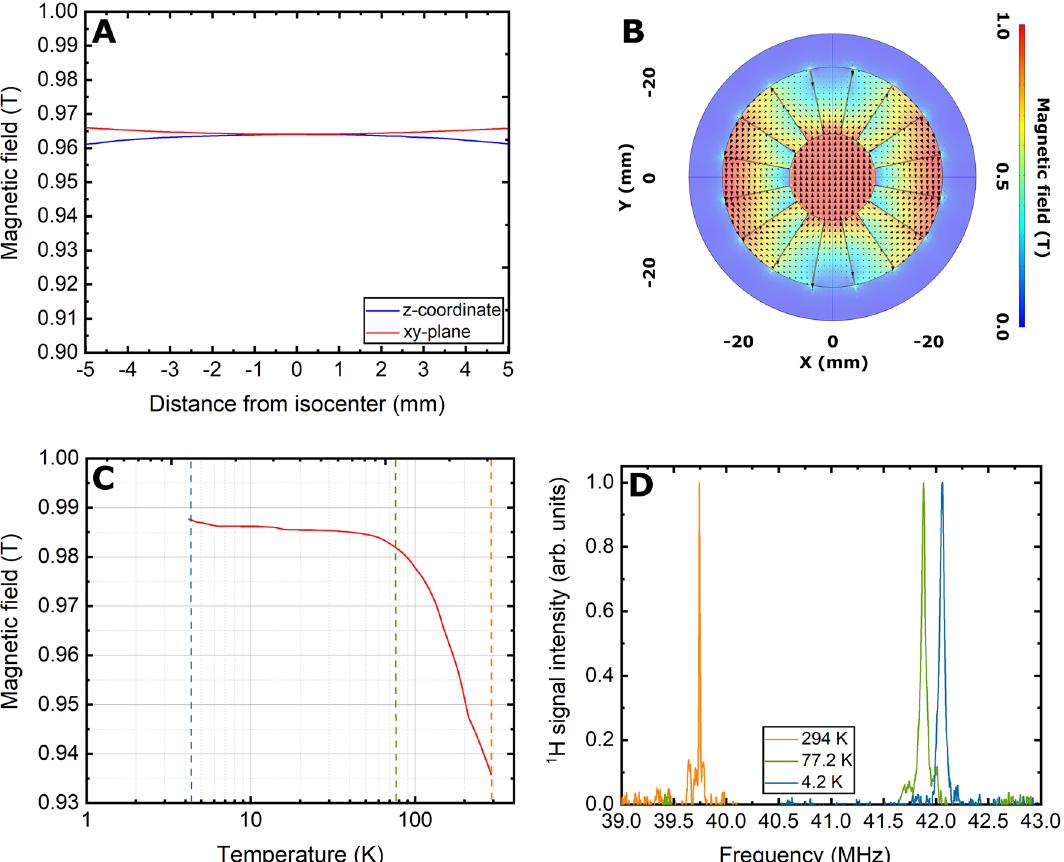
Figure 9. Magnetic field value simulation 10 mm across the storage magnet isocenter in the z- direction (blue curve) and y- direction (red curve); because of the magnet geometry, the solution evaluated on each diameter in the xy-plane is identical ( A ). 2D field map evaluated on transversal plane passing for the storage magnet isocenter ( B ). Storage magnet field drift as a function of temperature (red curve); measurements at 294 K, 7 K, and 4.2 K are indicated by the intersection with dashed lines in orange, green and blue colours, respectively ( C ). 1H NMR spectra collected at 294 K (orange), 77 K (green) and 4.2 K (blue) ( D